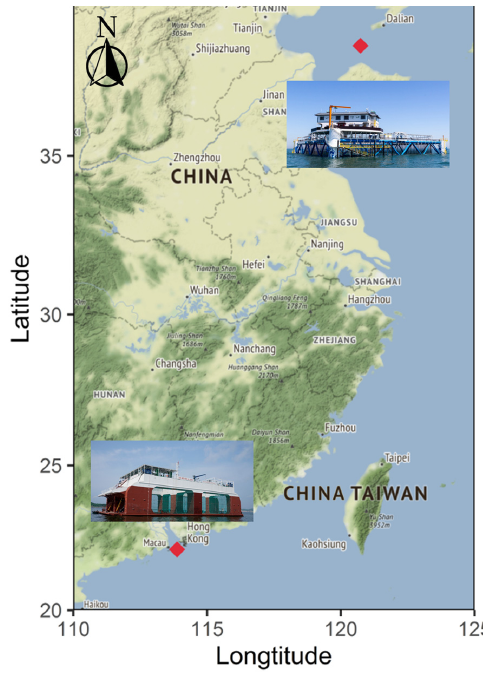
Figure 1. Study area.